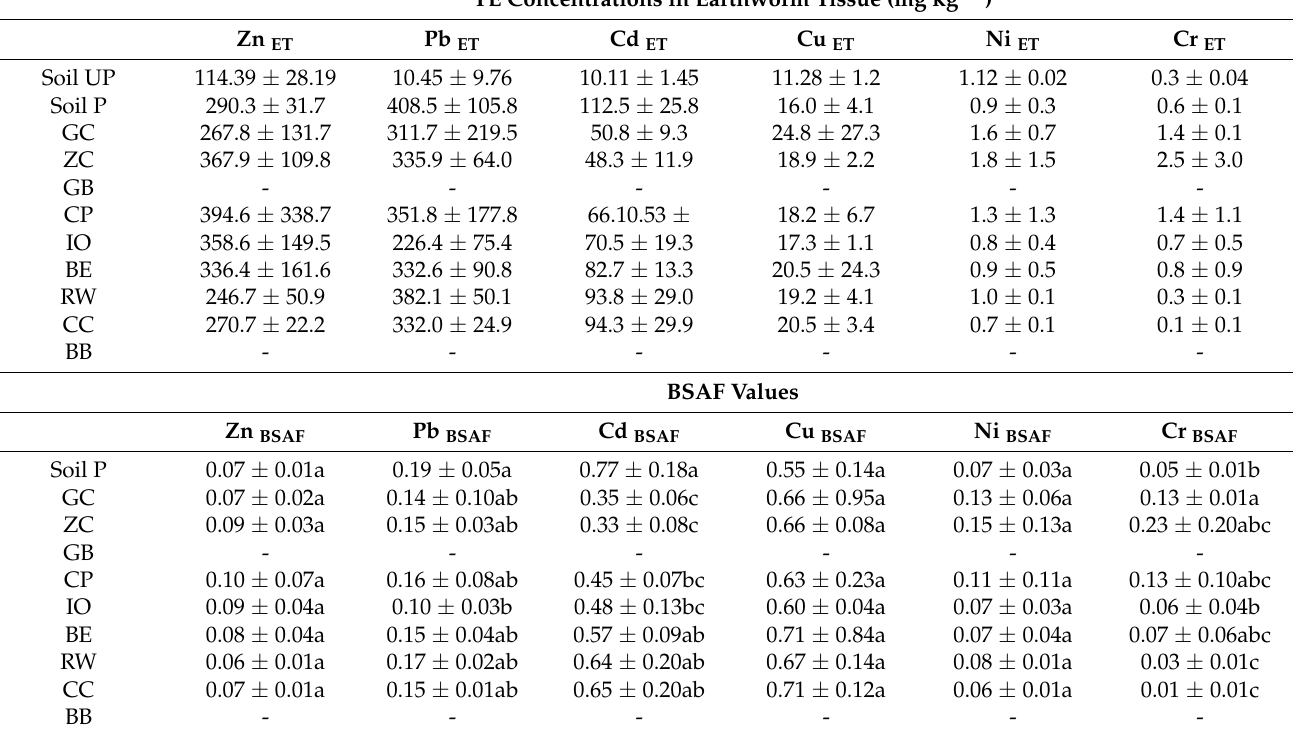
Table 2. TE accumulation and biota-soil accumulation factor (BSAF) values in the control and the amended soils (n =